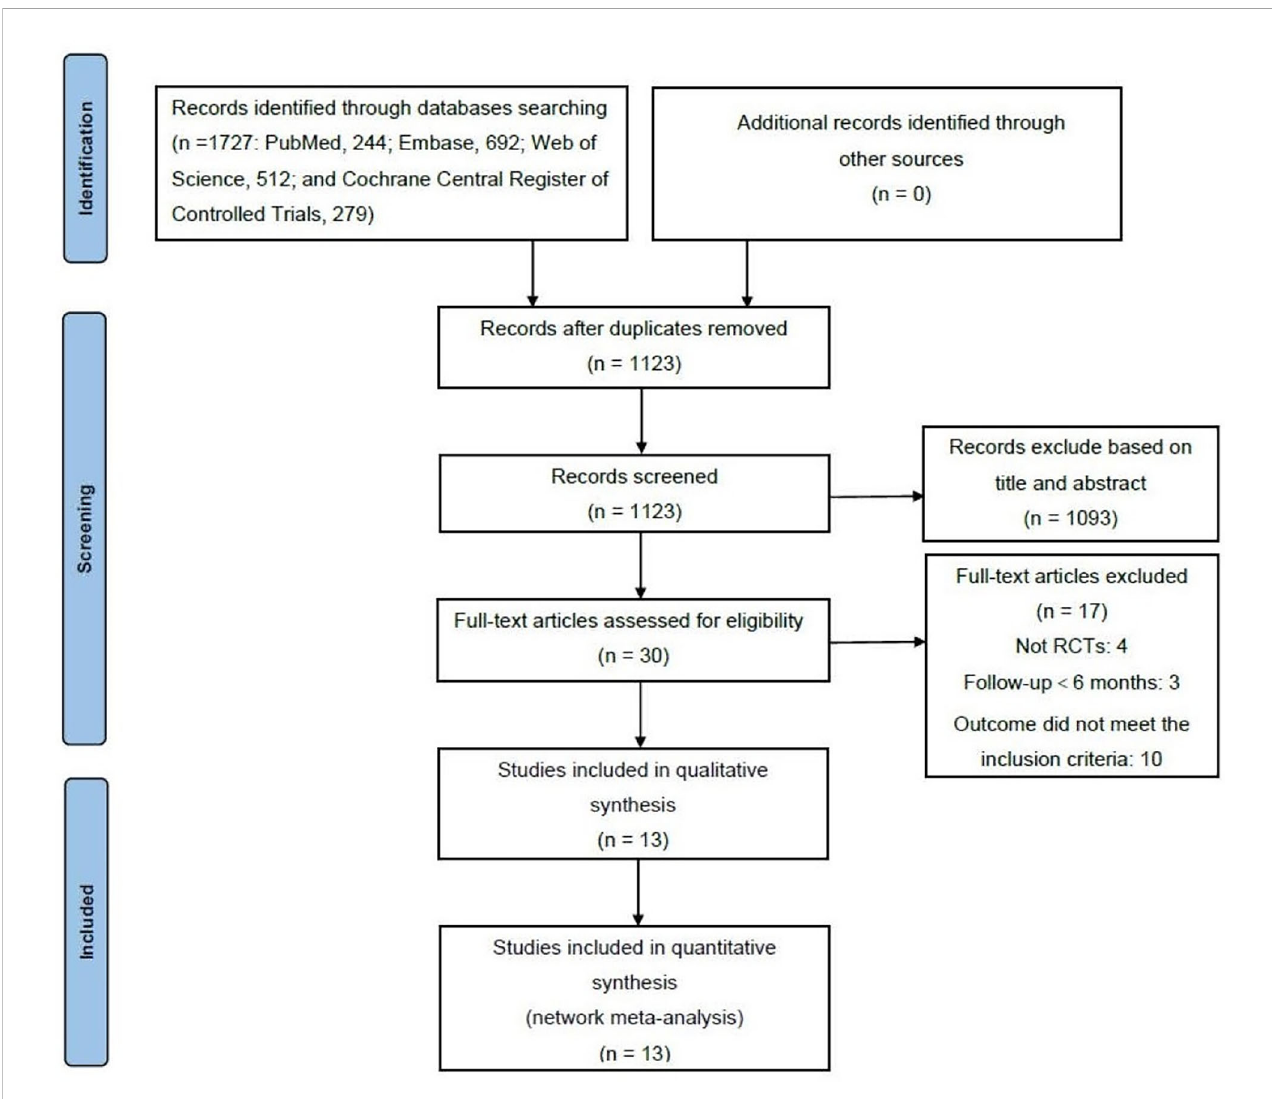
FIGURE 1 Flow chart depicting the selecting process of included